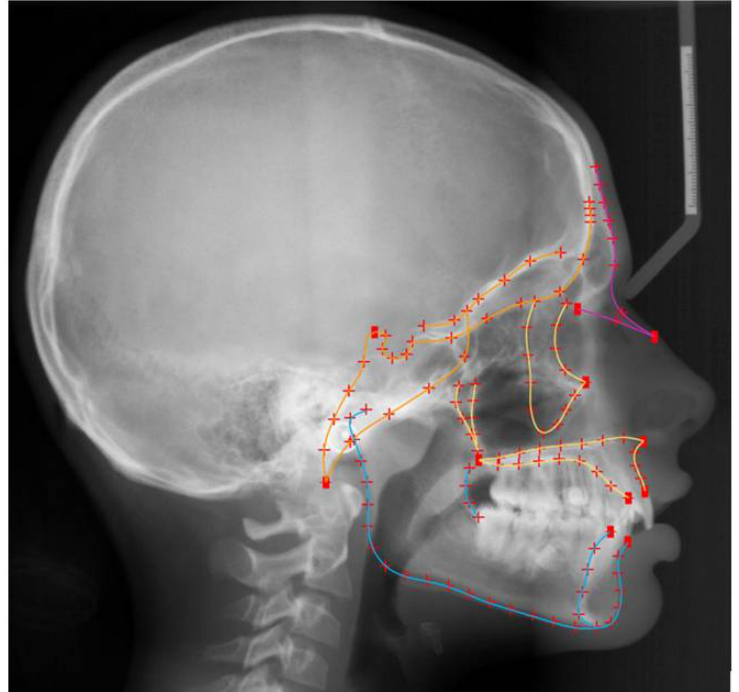
Figure 1. Material from Elias S. Oeschger et al. Number of teeth is associated with facial size in humans, Scientific Reports, published 2020, Springer Nature, licensed under CC BY 4.0. Craniofacial morphology was captured through the depicted landmarks. Digitization of the craniofacial complex (n = 808) with 15 curves, which included 116 semilandmarks (red crosses), and 11 fixed landmarks (red squares). Orange colour represents the structures of the cranial base, yellow the maxillary structures, blue the mandibular structures, and all lines together the entire